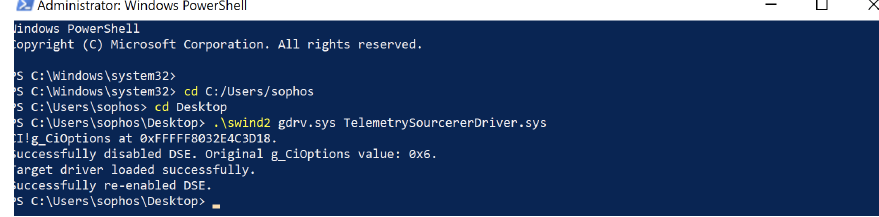
Figure 35. Loading an unsigned driver via gdrv-loader .